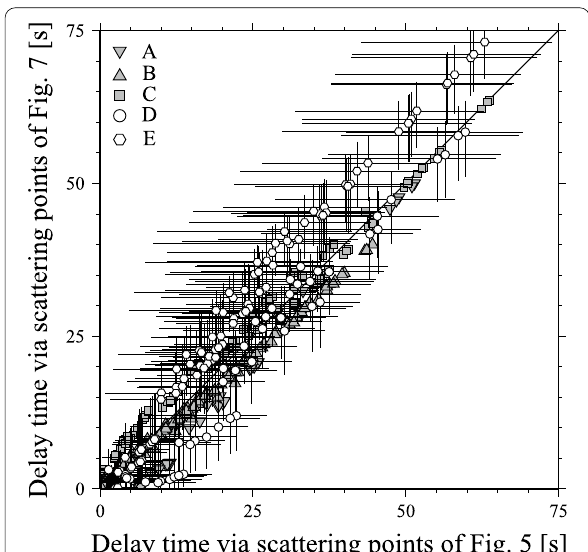
Fig. 8 Expected delay times of the scattered waves of backarc intraslab earthquakes, computed from the estimated passing points of the backarc earthquakes (Fig. 5) and forearc earthquakes (Fig. 7). Gray-filled symbols are the expected delay times in the cross-sections A–C. White symbols are the expected delay times in cross-sections D and E, and their temporal ranges corresponding to the 95% confidence intervals in the forearc region in Figs. 5 and